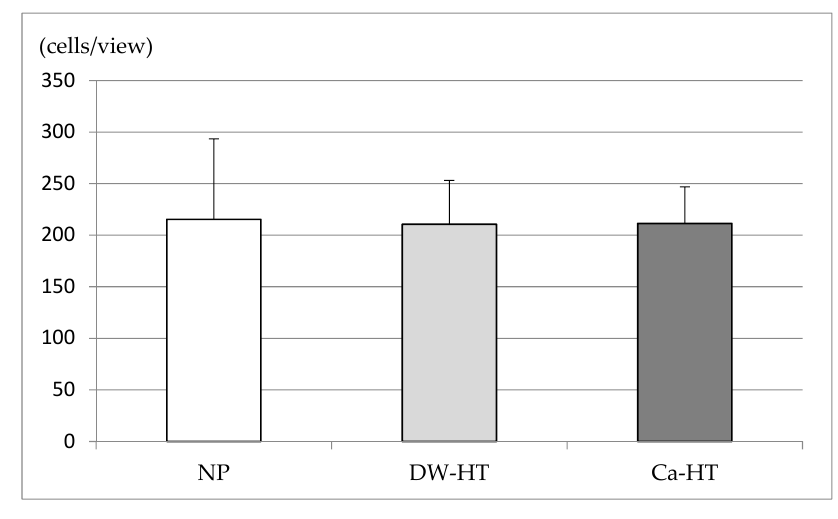
Figure 3. Bovine serum albumin (BSA) adsorption. BSA adsorption was significantly higher in both HT groups than in the NP group. No statistical differences were observed between the HT groups ( p < 0.05).